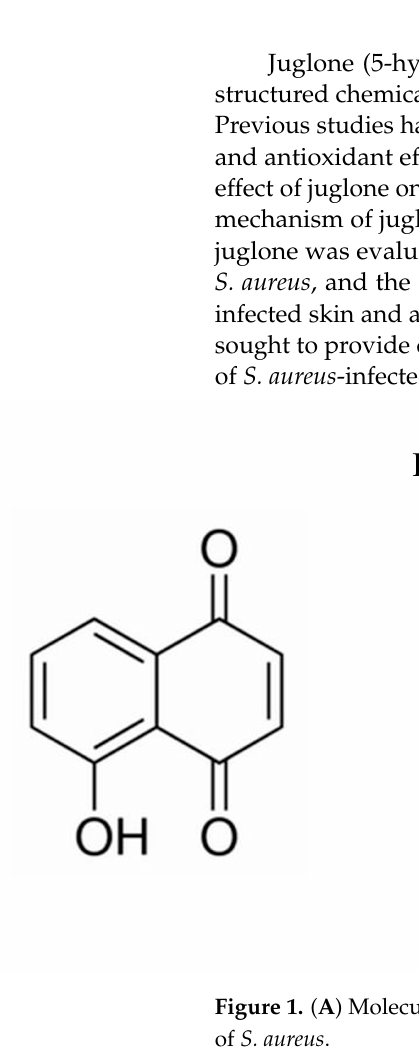
Table 1. Minimum inhibitory concentration (MIC) and minimum bactericidal concentration (MBC) of juglone against S. aureus